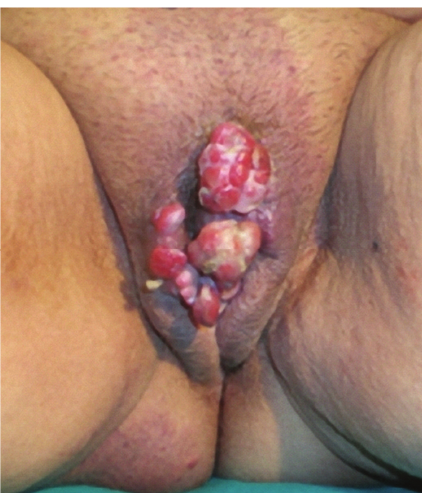
Figure 1: Appearance of multiple pyogenic granulomas of the vulva.